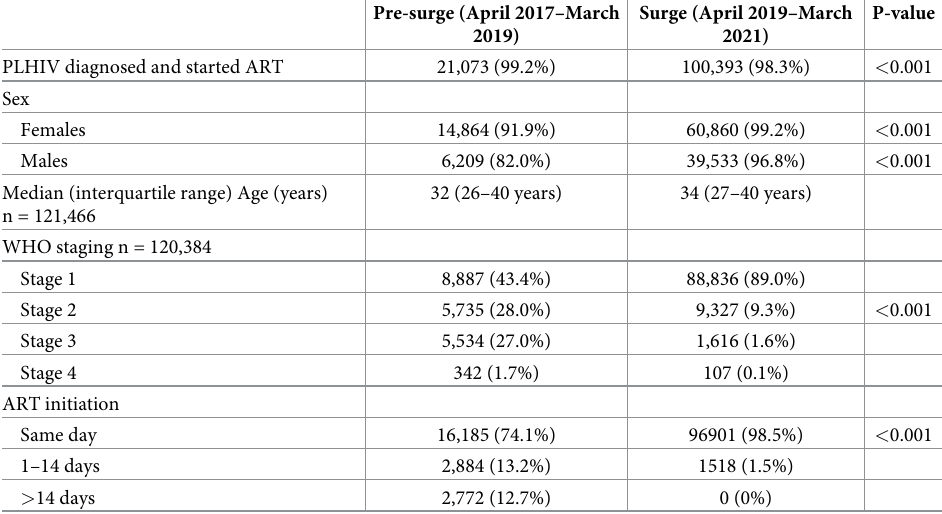
Table 5. Demographic and clinical characteristics of individuals initiated on ART before and during the surge, Akwa Ibom, Nigeria (April 2017 to March 2021).